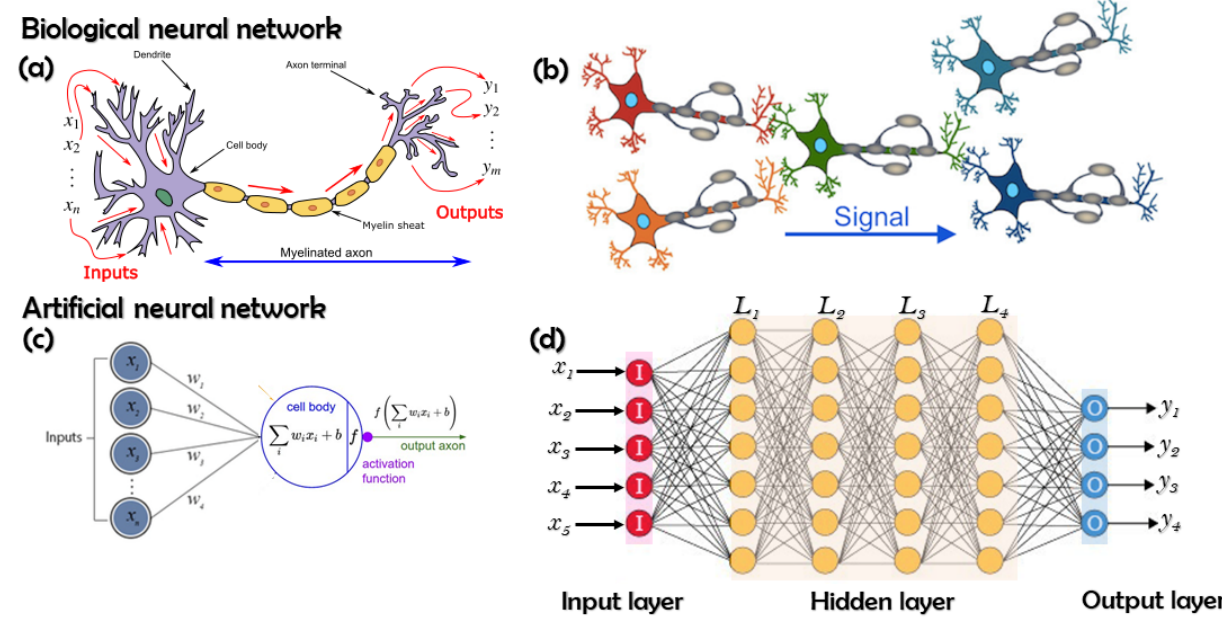
Figure 1. Biological ( a , b ) and artificial ( c , d ) neural